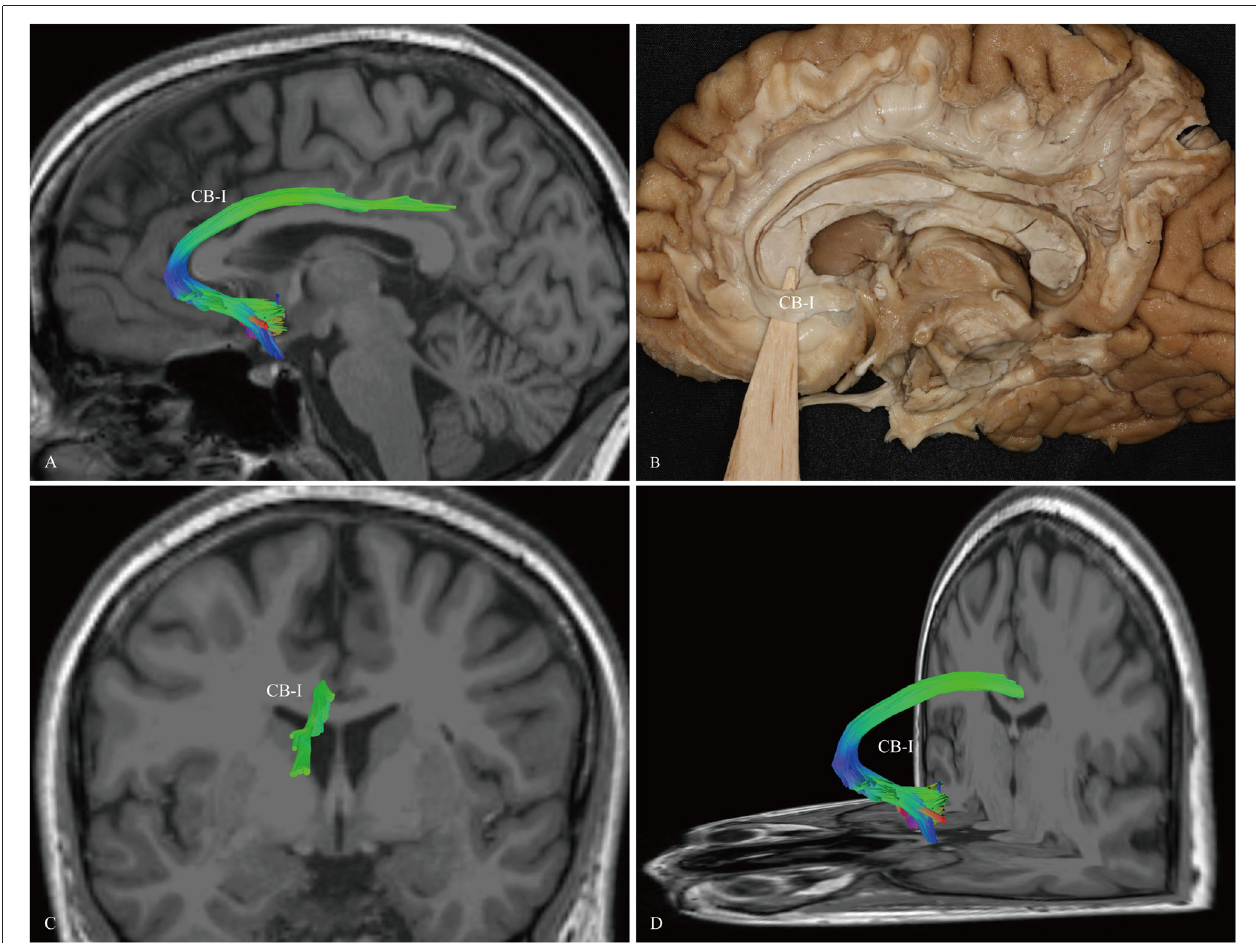
FIGURE 3 | In vivo fiber tractography and fiber dissection of the CB-I. (A,B) The CB-I runs from the subrostral areas in the orbital-frontal cortex anteriorly, then arches through almost 180 ◦ around the genu of the CC. (C,D) After that, the fibers continue above the body of the CC to the precuneus and splenium of the